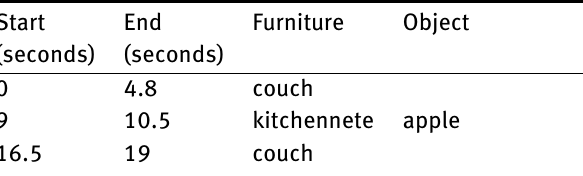
Table 1: The pick a snack scenario: ground truth